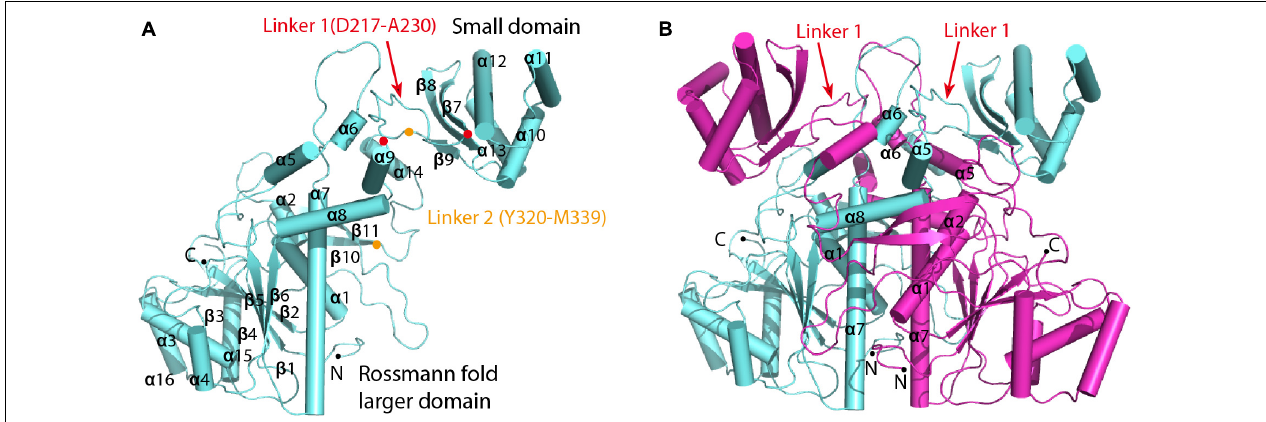
FIGURE 1 | Overall crystal structure of R. castenholzii MCT. (A) Overall structure of the subunit that comprises a dimer of MCT. Each subunit consists of a Rossmann fold larger domain and a small domain, which are joined together by two linker regions (Residues D217-A230 for linker 1 and Y320-M339 for linker 2). The N- and C-terminus, and amino acid residues located at the two ends of the linker are indicated as dots. (B) The conformation of the dimer. Two subunits are cross interlocked at the linker regions, wherein α 5, α 6, α 7, and α 8 from each subunit symmetrically interacted in the center of the dimer interface.